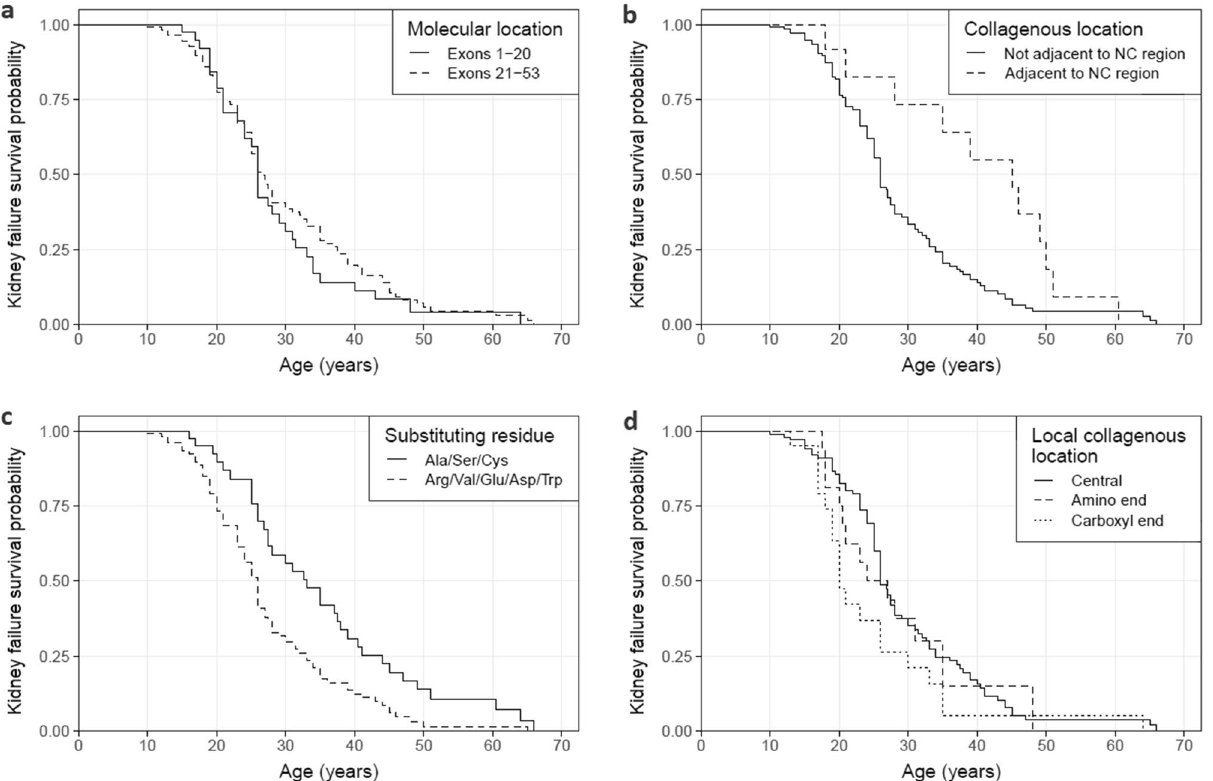
Figure 2. Proportion of cases without kidney failure for COL4A5 Gly missense variants reported in LOVD. Variants were stratified by ( a ) molecular location (p = 0.41), ( b ) collagenous location (p = 0.014) and ( c ) substituting residue (p = 0.002). ( d ) Excluding variants affecting NC boundary residues, variants were further stratified by relative location within their local collagenous region (p = 0.14). Censored data points are not shown. NC,